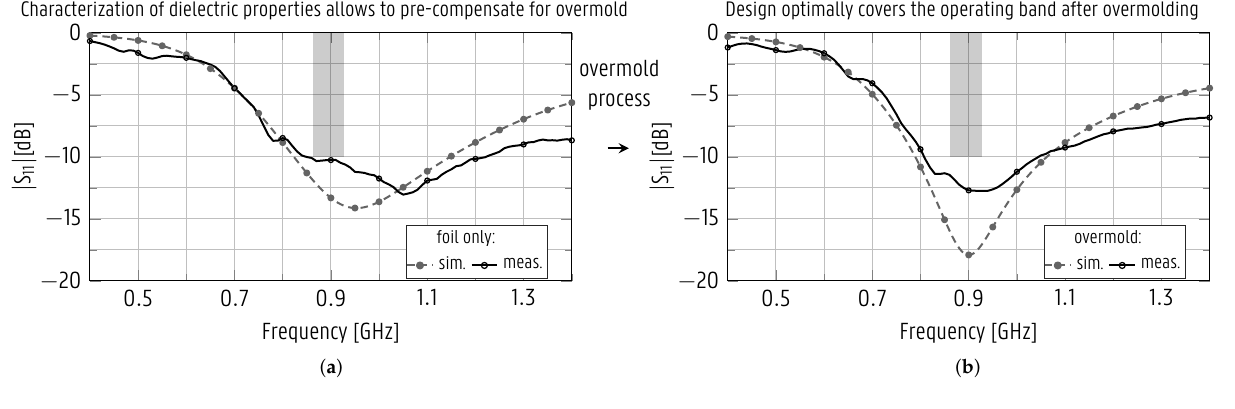
Figure 6. Simulated and measured magnitude of the reflection coefficient of the monopole antenna ( a ) printed on plastic foil and ( b ) after overmolding. Stand-alone prototypes fed with U.FL connector (shown on the left of Figure 4).